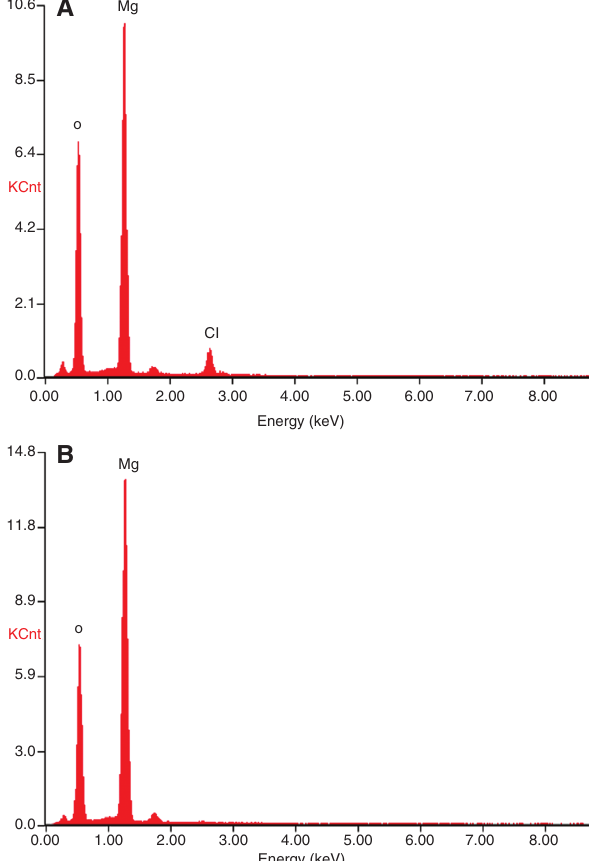
Figure 4 Typical EDS spectra of the products obtained by thermal plasma process: (A) before treatment with feeding rate of 1.50 ml/ min; and (B) its corresponding product after